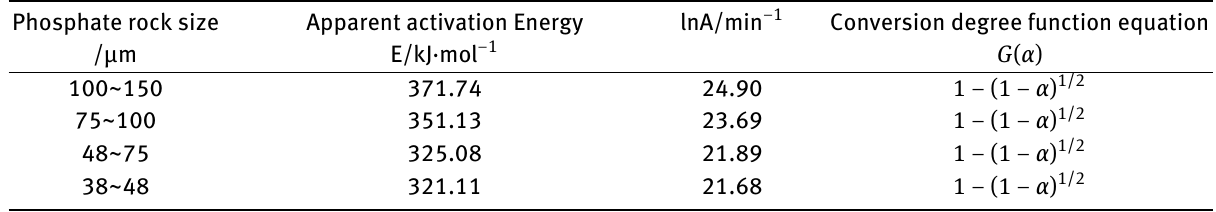
Table 5: Kinetic parameters of carbothermal reduction process of phosphate rock with different particle sizes Phosphate rock